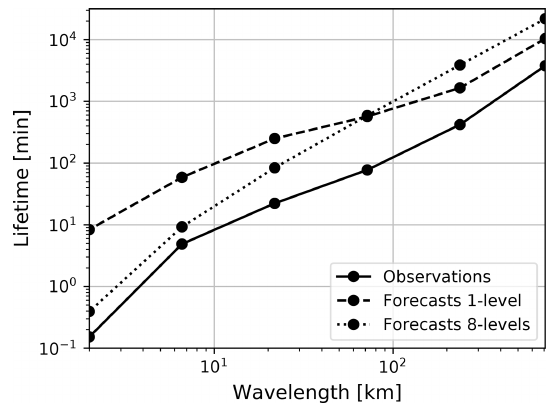
Figure 17. Verification of dynamic scaling properties of stochas- tic nowcasts generated with one and eight cascade levels. All Me- teoSwiss events were analyzed, but nowcasts were run only ev- ery